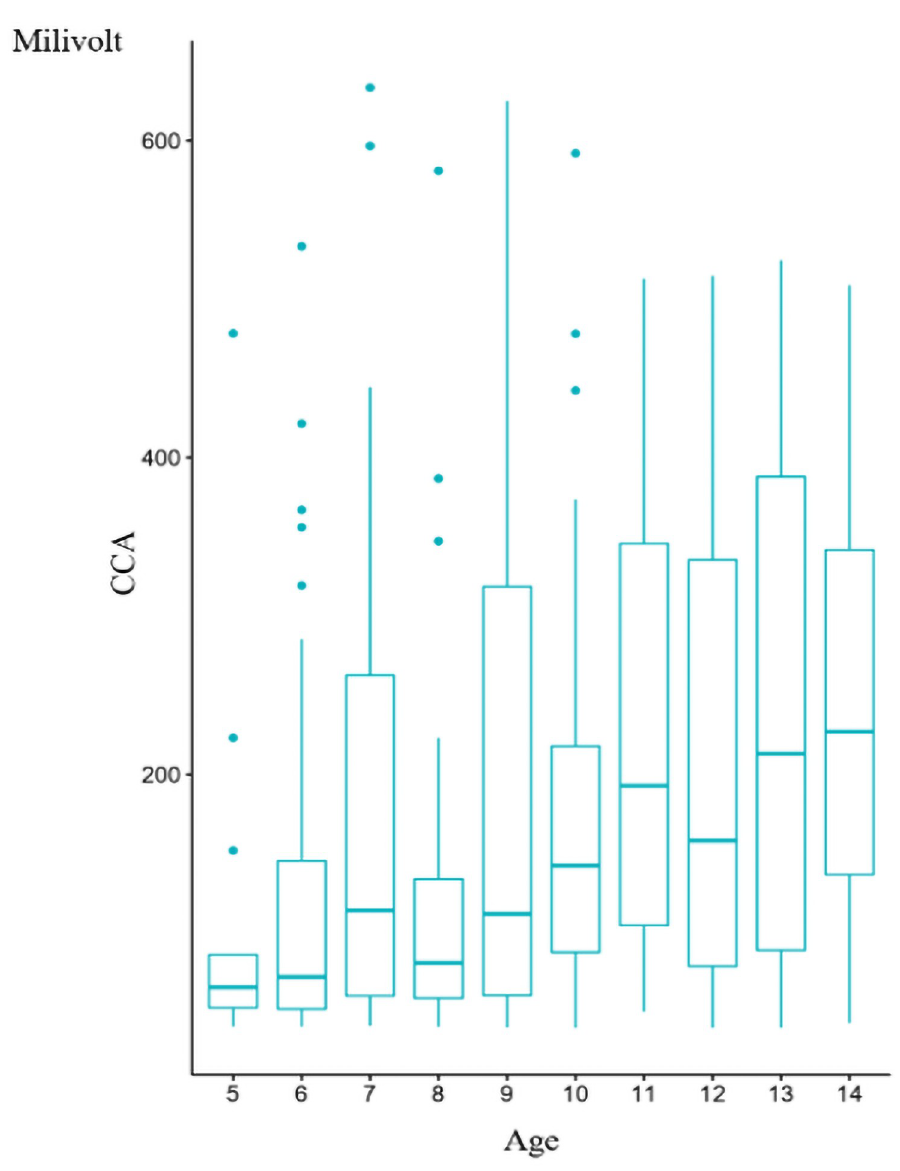
Fig 2. Correlation between mean POC-CCA values on fresh urine samples and age of